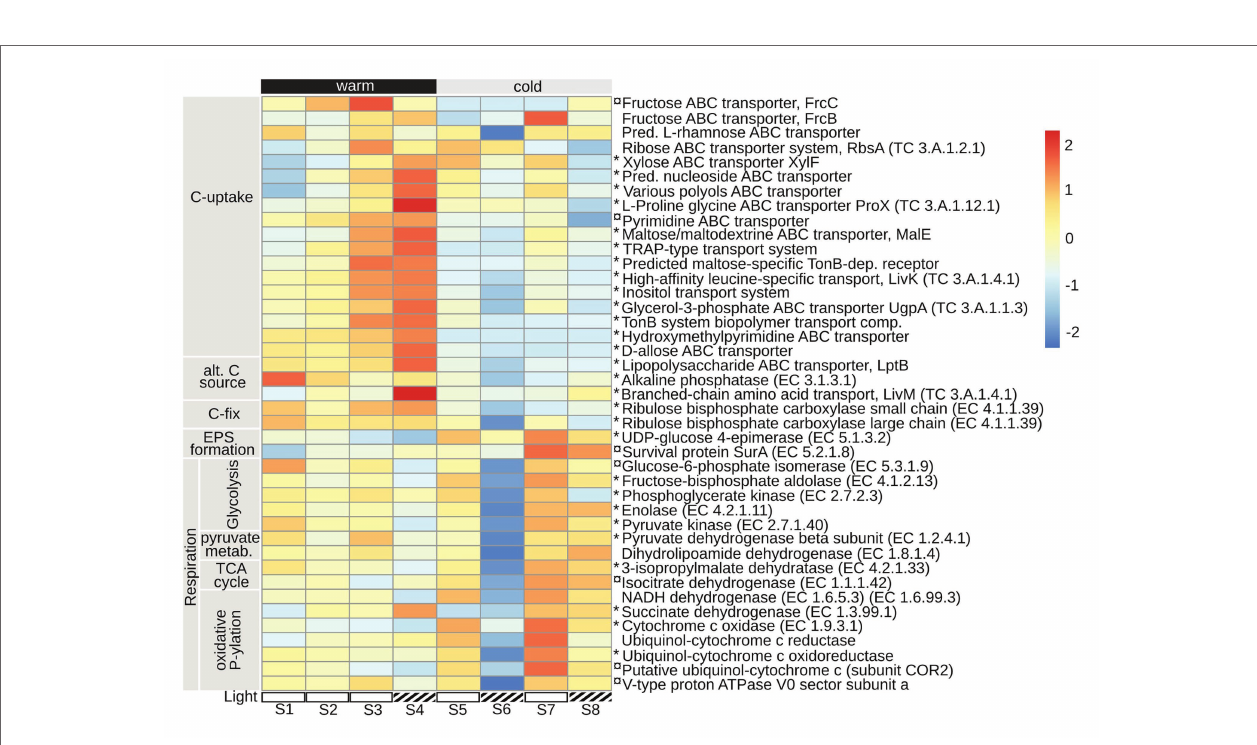
FIGURE 6 | Prokaryote gene expression (excluding transcripts annotated as eukaryotes in the prokaryotic dataset) of mechanisms associated with carbon acquisition, putative extracellular polysaccharide (EPS) formation, and respiration. Included are key enzymes representative of: carbon uptake (C-uptake), alternative carbon sources, carbon fixation, EPS-formation, glycolysis, pyruvate metabolism, tricarboxylic acid (TCA) cycle, and oxidative phosphorylation. Heatmap shows the mean of triplicates per sampling date (S1–S8), normalized to TPM and square-root transformed, made using R package pheatmap, with setting scale by “row.” Warm: 19.5 ± 0.89 ° C, cold: 12.4 ± 1.76 ° C (mean temperature per 24 h in PBR); Light: light reduction, open bar → natural light, striped bar → light reduced by 40– 60% by shading. * indicate p adj < 0.01, and ¤ p adj < 0.05, for log2 fold change, differential expression, contrasted for warm vs. cold time